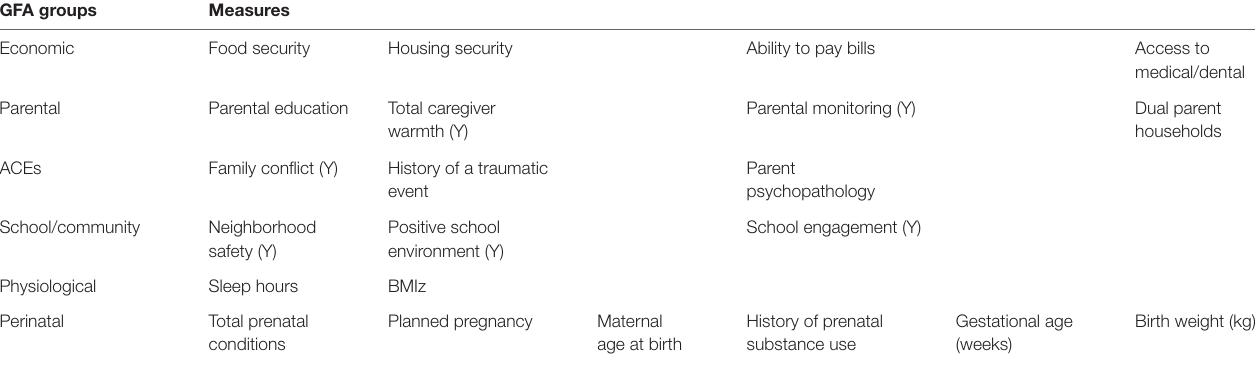
TABLE 2 | List of grouped measures entered into the Group Factor Analysis (GFA) encompassing economic security, psychosocial ecologies (parental, ACEs, and school/community), physiological and perinatal domains, across parent report and youth (Y) report. GFA